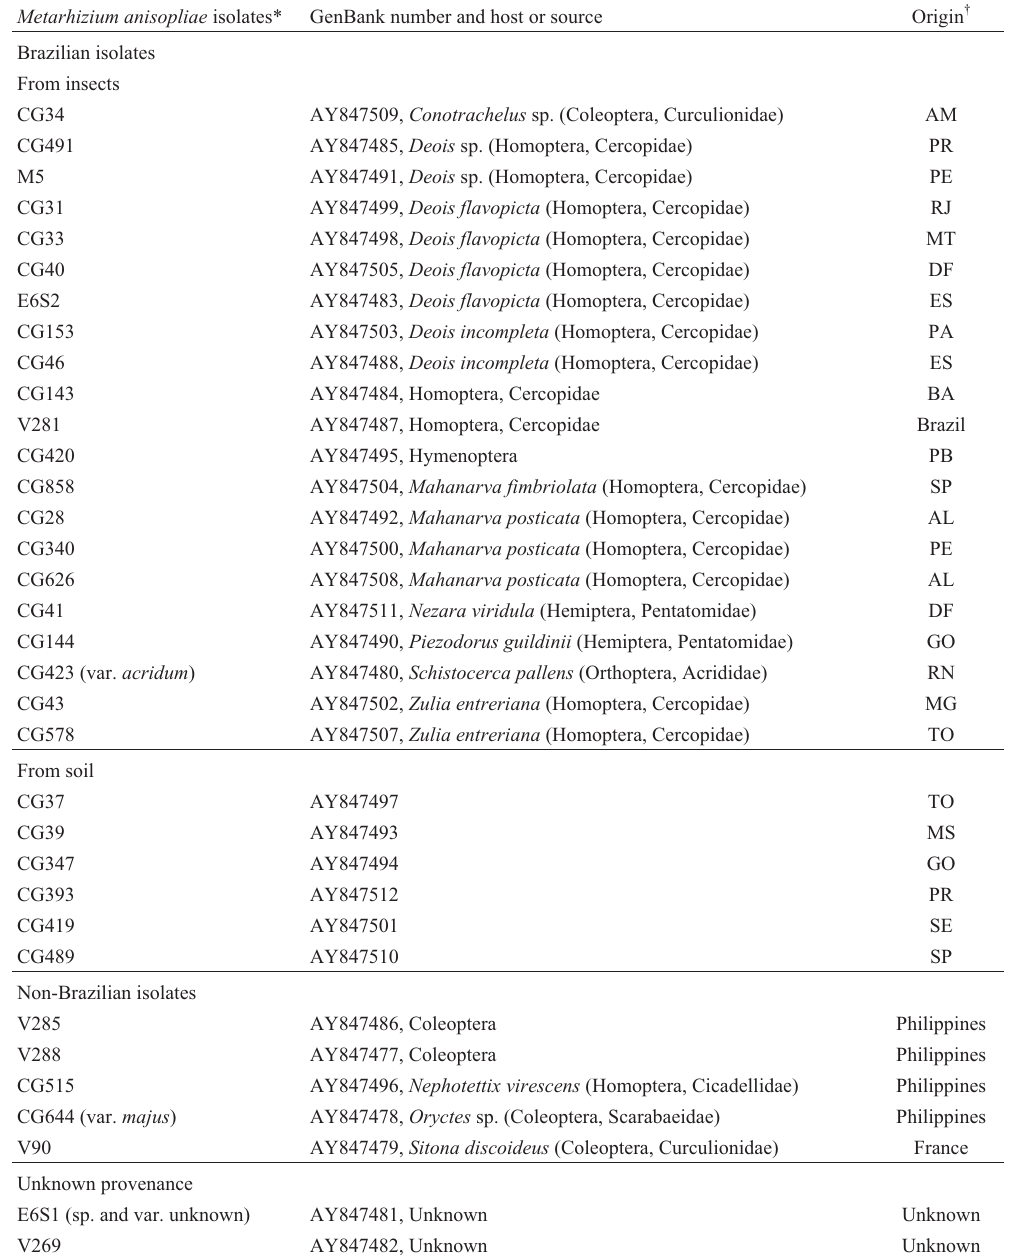
Table 1 - The Metarhizium anisopliae isolates characterized in this study, their hosts and geographic origins. Except where indicated all isolates were Metarhizium anisopliae var.